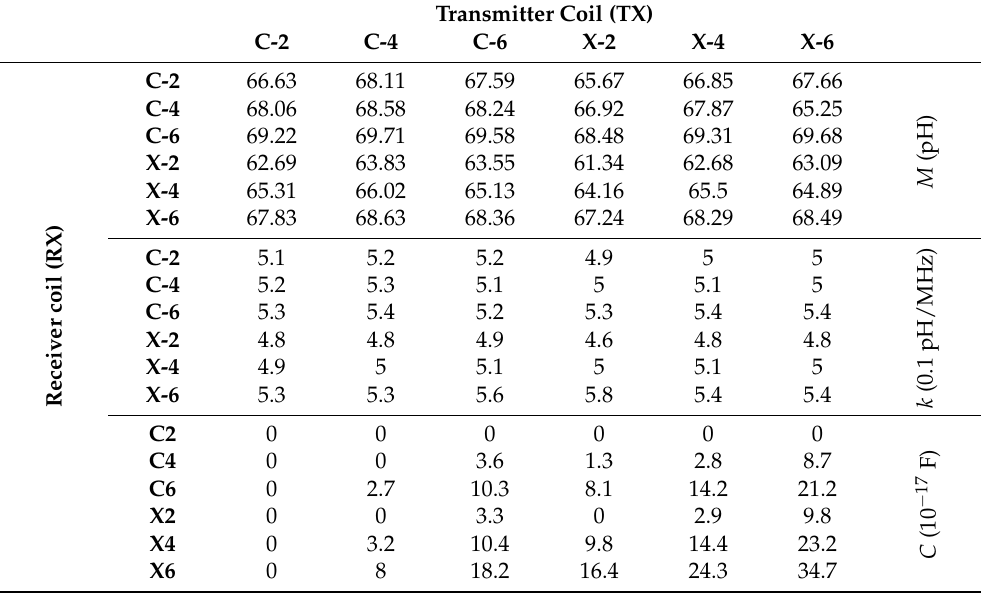
Table 3. Model parameters, 27 cm intercoil separation.